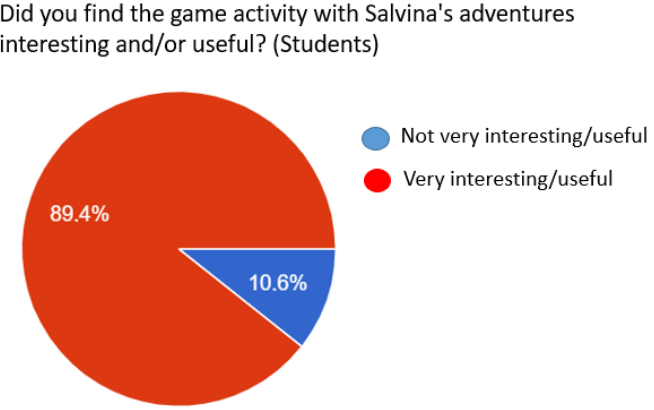
Figure 11. Pie chart showing cumulative percentage of the feedback received for the third question